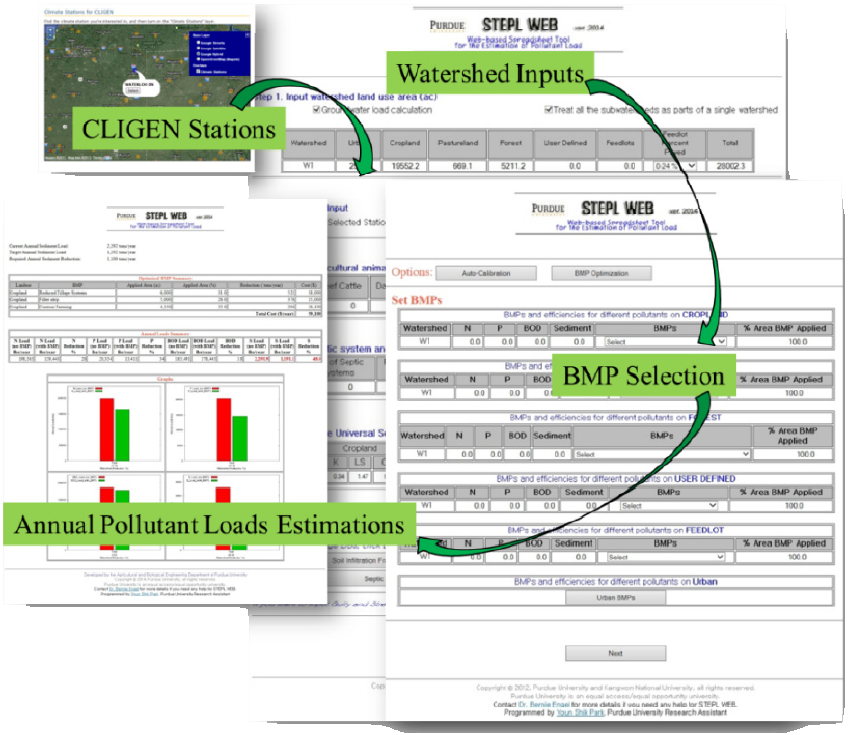
Figure 2. Web-based Spreadsheet Tool for the Estimation of Pollutant Load (STEPL) (STEPL WEB) interfaces and annual pollutant loads estimation. BMP, best management